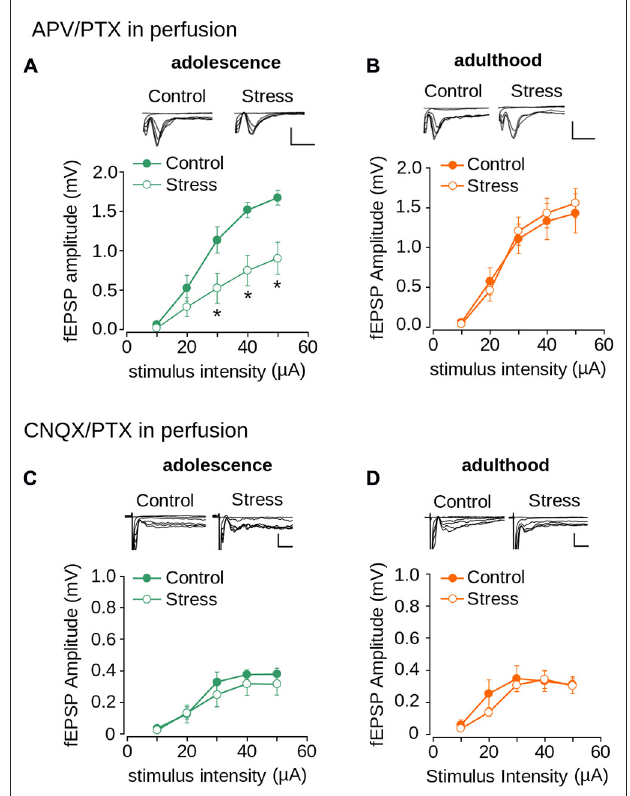
FIGURE 6 | Effect of repeated stress on AMPA/kainate receptor and NMDAR-mediated synaptic transmission in layer 1 of mPFC during adolescence and adulthood. (A,B) Upper panel, representative superimposed traces of the fEPSP evoked under different stimulus intensities in the presence of PTX 1 µ M and 50 µ M APV for control and stress groups during adolescence (A) and adulthood (B) (Scale bar: 1 mV; 5 ms). Lower panel, input-output relationship of fEPSP amplitude as a function of stimulus intensity during co-application of PTX and APV for control and stress groups during adolescence (A) and adulthood (B) . Significant difference between groups ( ∗ p < 0.05; Bonferroni post hoc test). Data are expressed as mean ± SEM. (C,D) Upper panel, representative traces of the fEPSP evoked under different stimulus intensities in ACSF without Mg 2 + in the presence of PTX 1 µ M and 50 µ M CNQX for control and stress groups during adolescence (C) and adulthood (D) (Scale bar: 0.5 ms; 10 ms). Lower panel, input-output relationship of fEPSP amplitude as a function of stimulus intensity during co-application of PTX and CNQX for control and stress groups. Data are expressed as mean ± SEM (n = 4 animals per group; 10-12 slices per group).